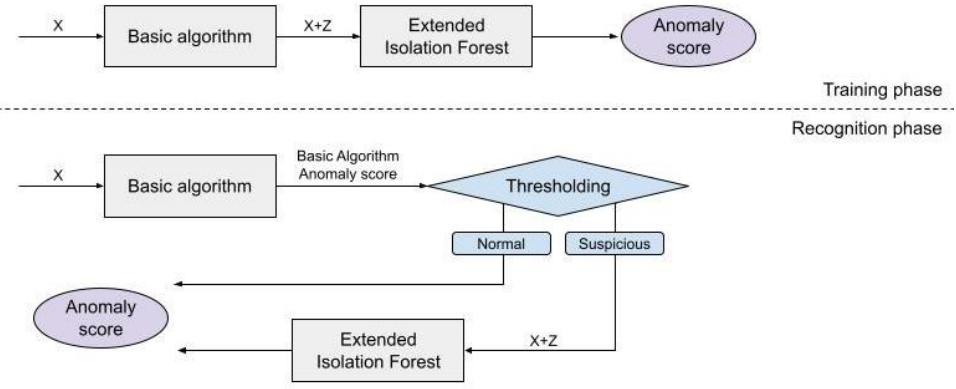
Figure 1. Description of the training phase and recognition phase of the proposed